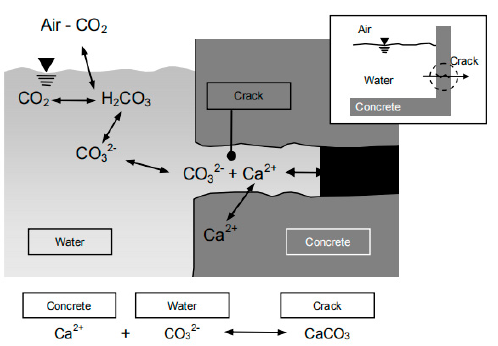
Figure 1. Self-repairing mechanism (ongoing hydration process) [9].